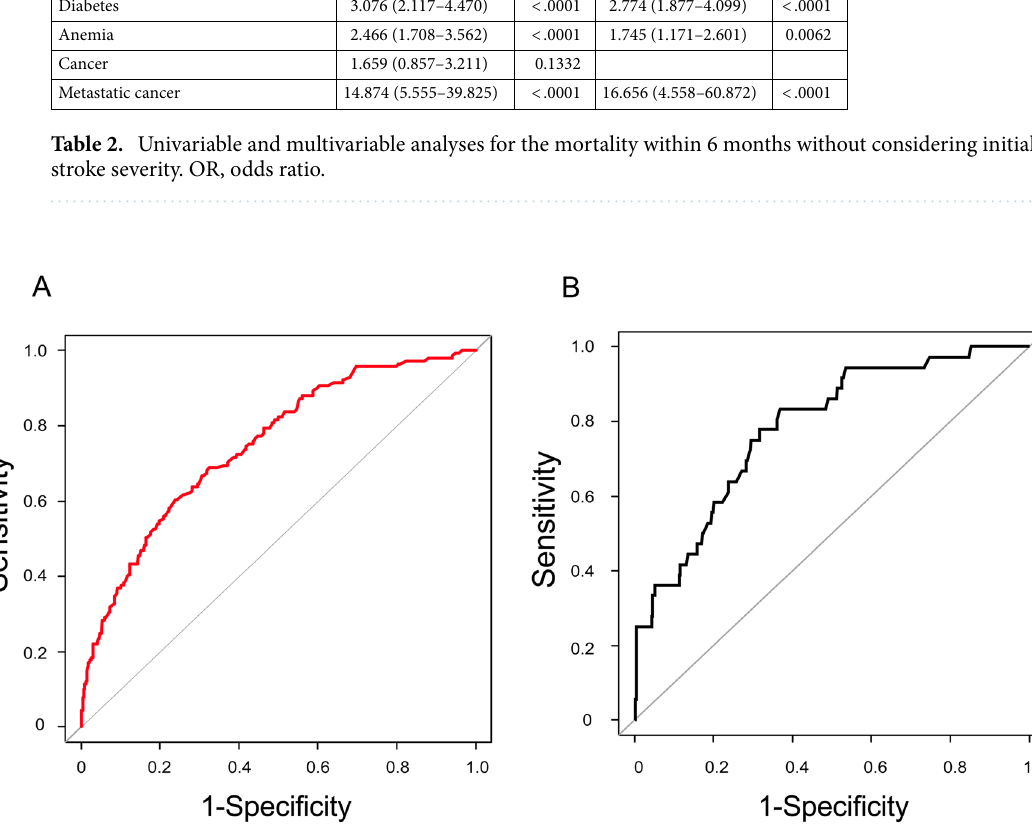
Figure 3. Internal validation ( A ) and external validation ( B ). The predictive ability of the reperfusion comorbidity index for 6-month mortality showed an area under the curve (AUC) of 0.747 (95% CI, 0.704–0.790) in retrospective cohort ( A ). In the prospective cohort, the predictive ability of the reperfusion comorbidity index was AUC of 0.784 (95% CI, 0.709–0.859) ( B